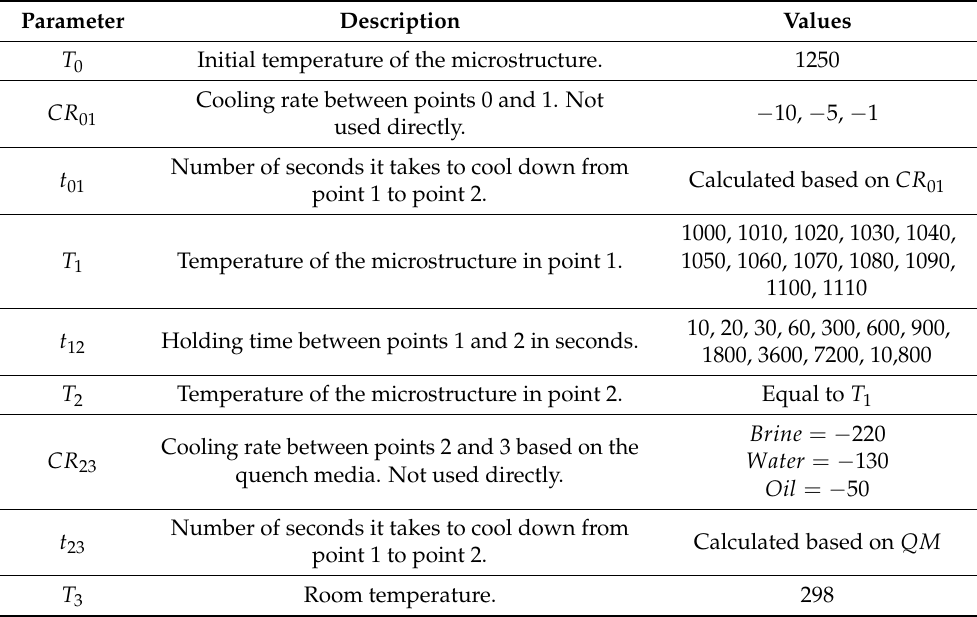
Table 5. Heat treatment parameters and their values. The units for temperatures, times, and cooling rates are Kelvin, seconds, and K , respectively. s Parameter Description Values T 0 Initial temperature of the microstructure.